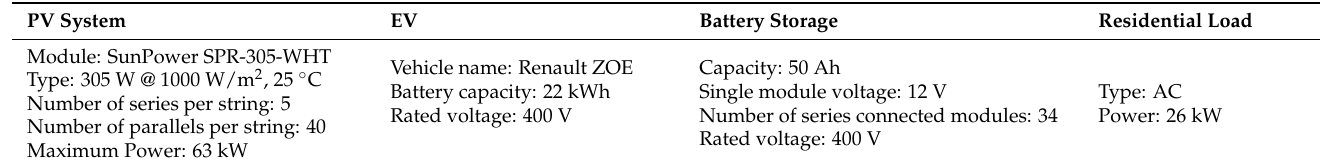
Table 1. Residential system component